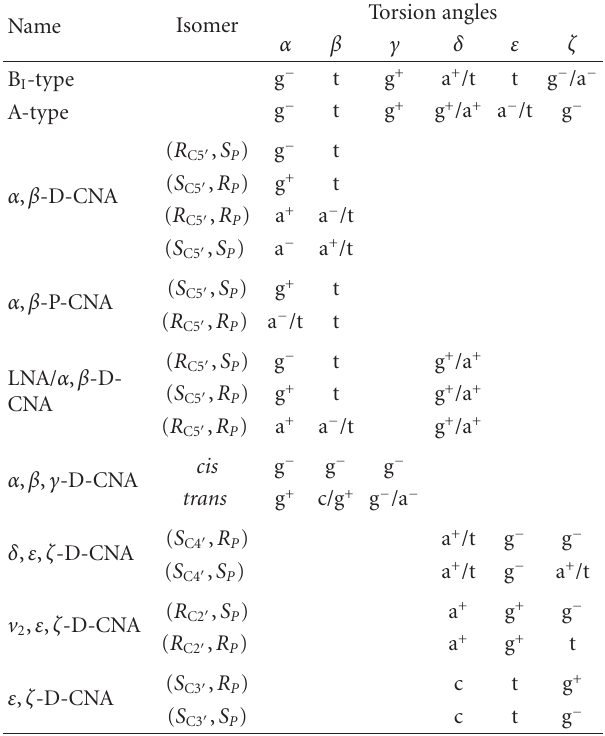
a The following 6-fold staggered pattern of the torsional angles is used: cis : 0 ± 30 ◦ (c), gauche (+) = 60 ± 30 ◦ (g + ), anticlinal (+): 120 ± 30 ◦ (a + ), trans